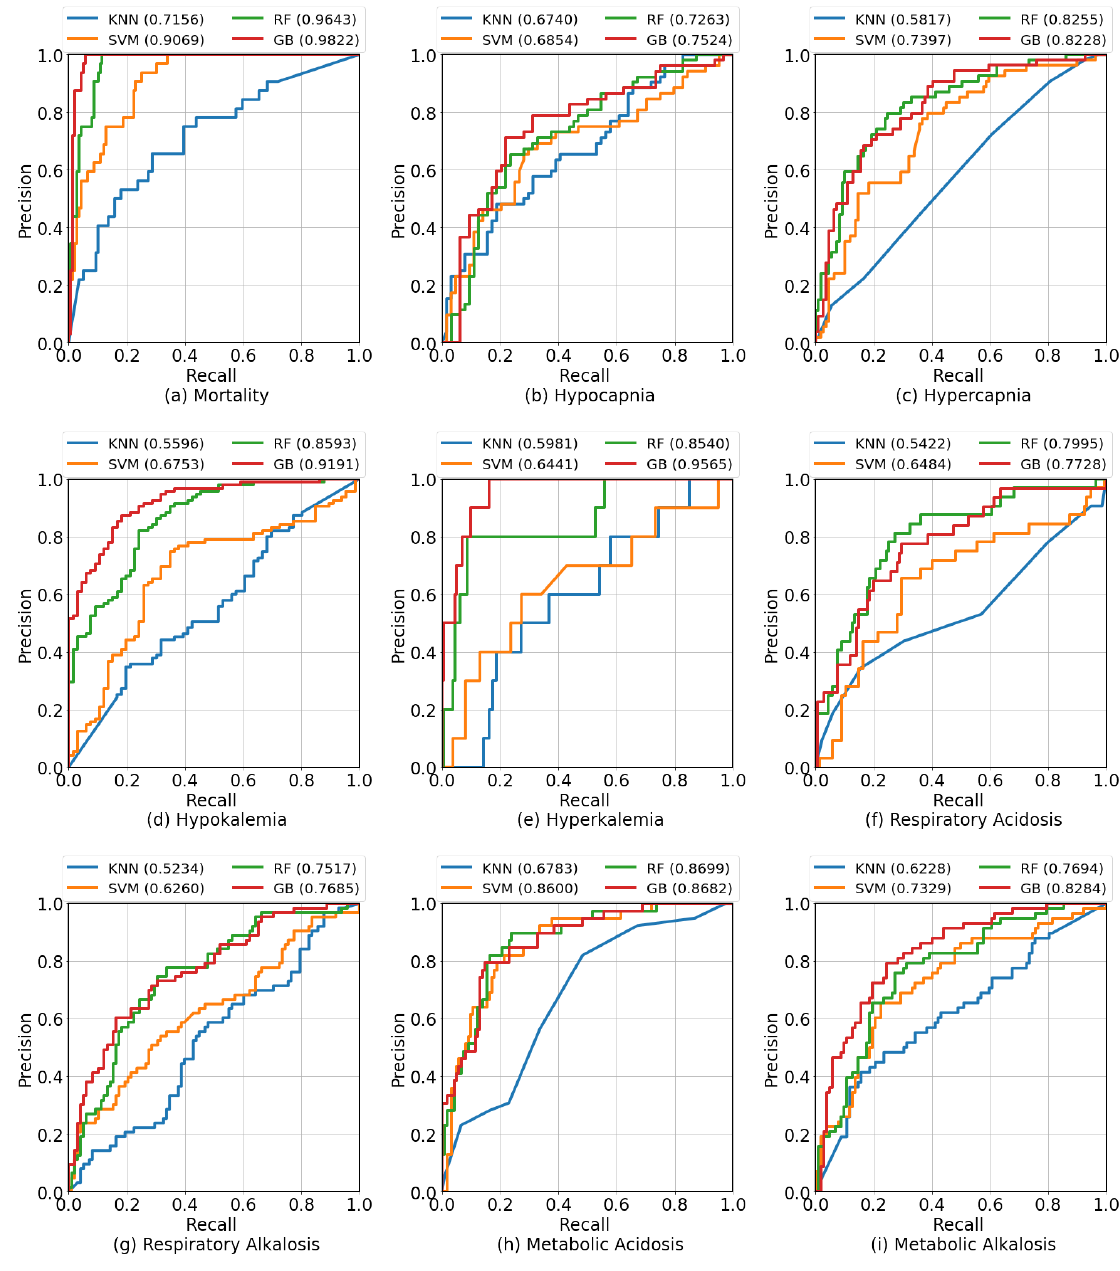
Figure 4. The ROC curves compare different algorithms for each target clinical condition. GB outperformed the other algorithms in most cases. There was a small number of positive cases for